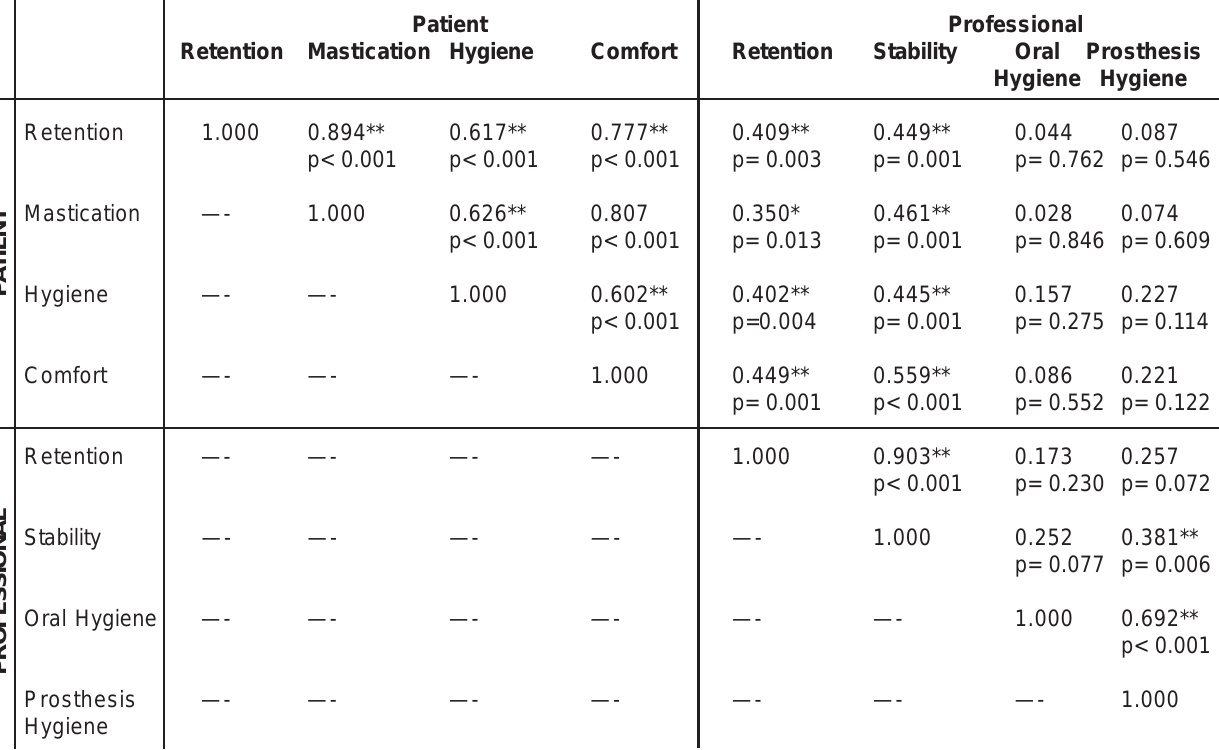
** Significant at the 0.01 level of